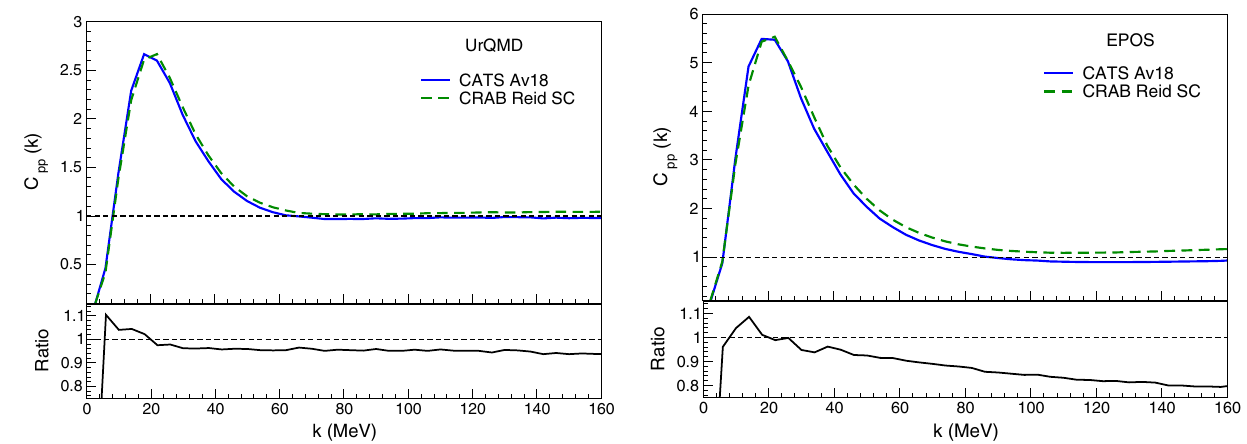
Fig. 5 Correlationfunctionforp–ppairsobtainedwithinUrQMDsim- √ s NN = 3 . 18 GeV (left panel) and within ulations for p–Nb reaction at √ s = 7 TeV. For both setups results are EPOS for pp collisions at Fig. 6 Correlation functions for p–p pairs (upper panel) and p– (cid:2) pairs (lower panel) for different interaction potentials (see 2.2) and emitting source